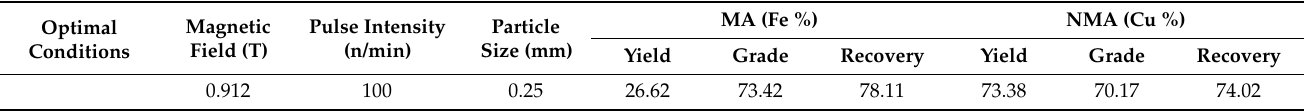
Table 8. The results of high-gradient magnetic separation under optimal conditions.